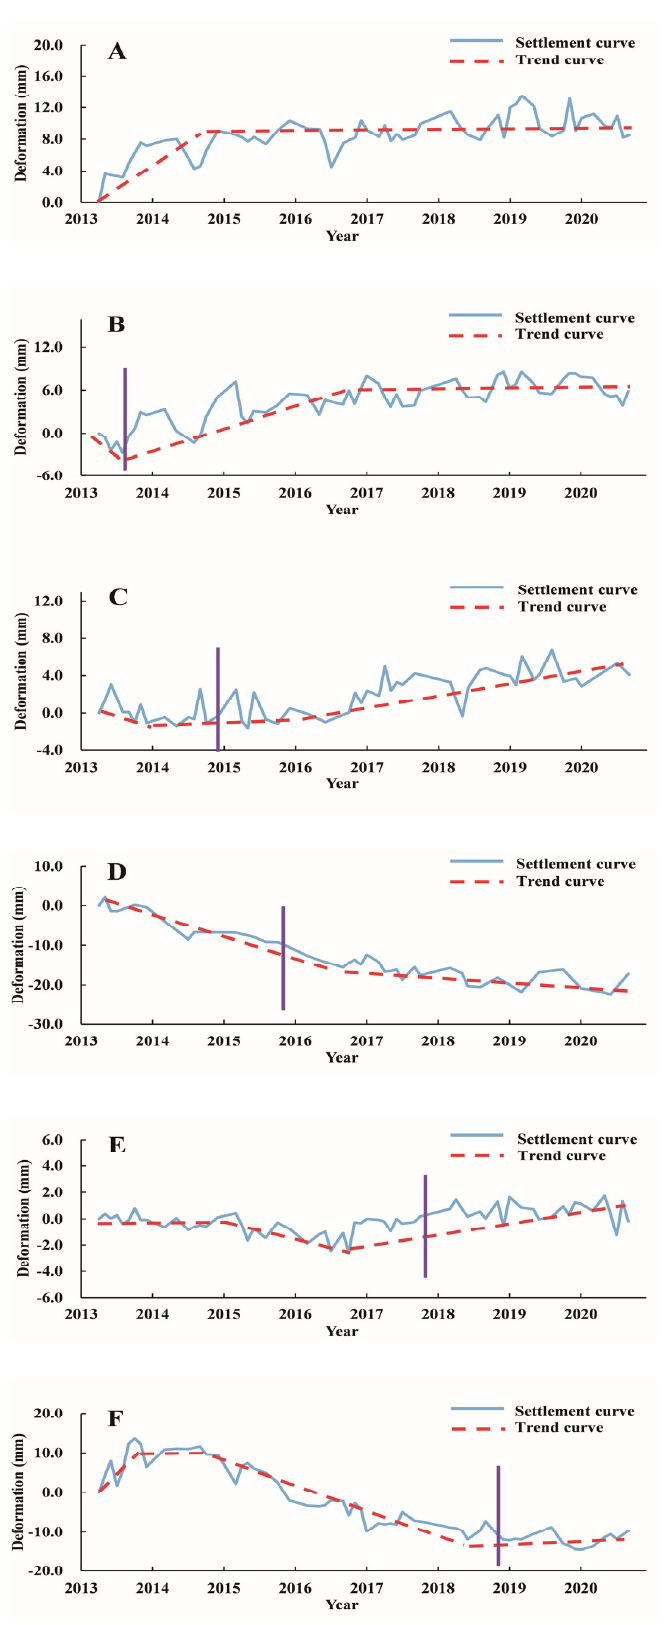
Figure 9. Curve of time series ground deformation along the subways in Shanghai from 2013 to 2020 (purple lines represent the time of opening to traffic). Plots ( A – F ) shows the ground deformation characteristics respectively in the six areas, labeled as A , B , C , D , E , F